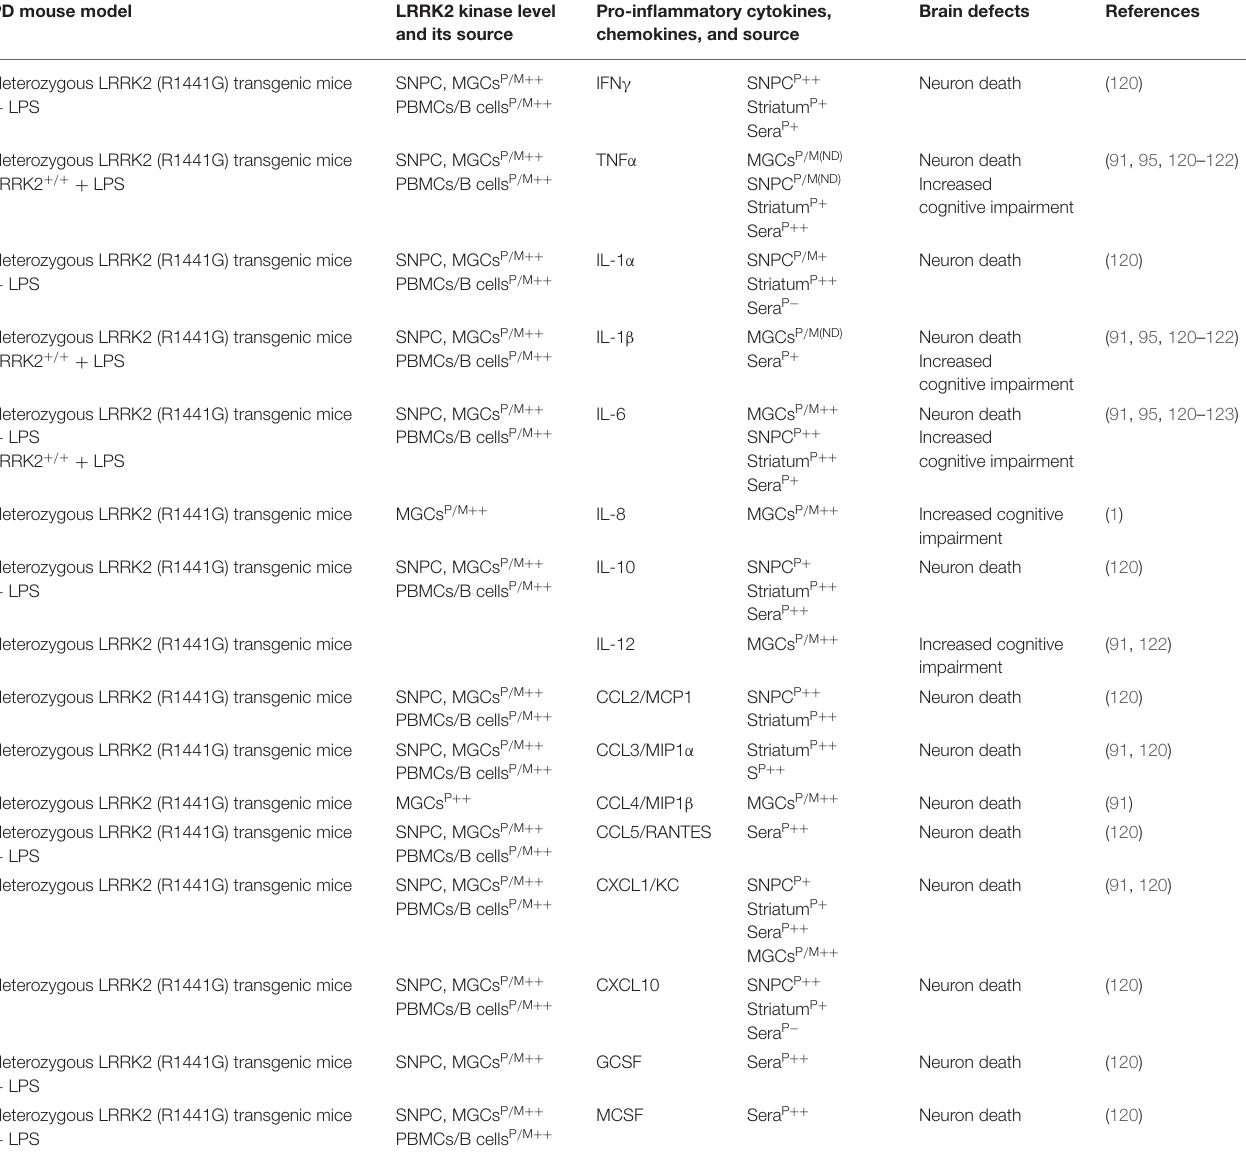
TABLE 2A | Cytokines and their source in the LRRK2 mouse model of PD. PD mouse model LRRK2 kinase level and its source